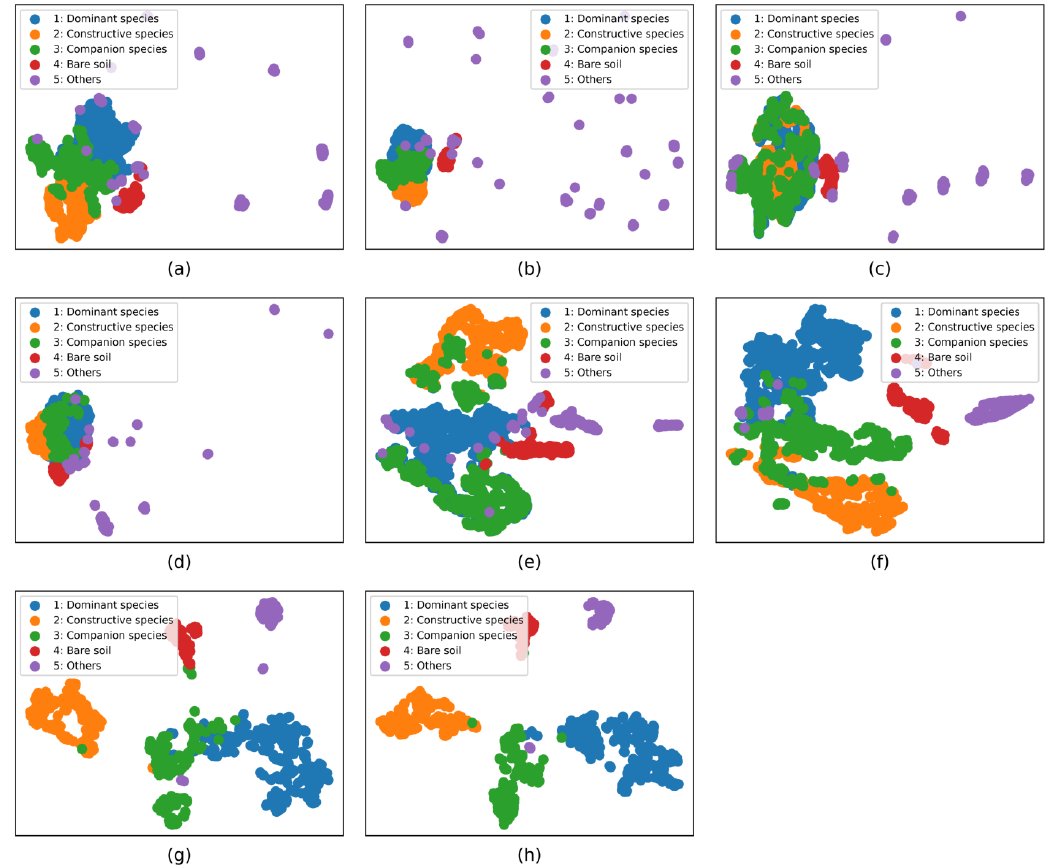
Figure 9. Results of feature visualization for different models. ( a ) MLP, ( b ) 1DCNN, ( c ) 2DCNN, ( d ) 3DCNN, ( e ) Resnet18, ( f ) Densenet121, ( g ) SN_GCN, and ( h ) SN_DGCN.